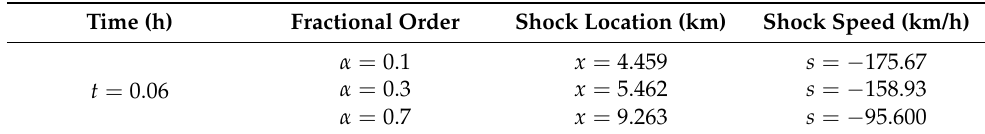
Figure 3. Schematic diagram for moving shock wave start at the location x = 15 km with α = 0.7 and t = 0.06 h. Table 1. Shock location and speed for various fractional-order